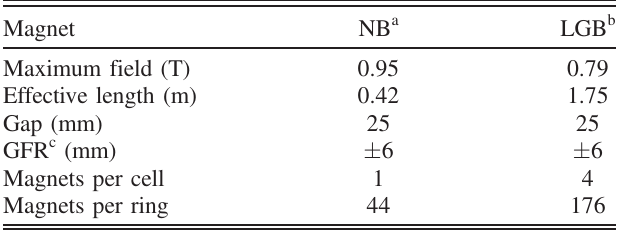
TABLE I. Specifications of bending magnets for SPring-8-II (interim).